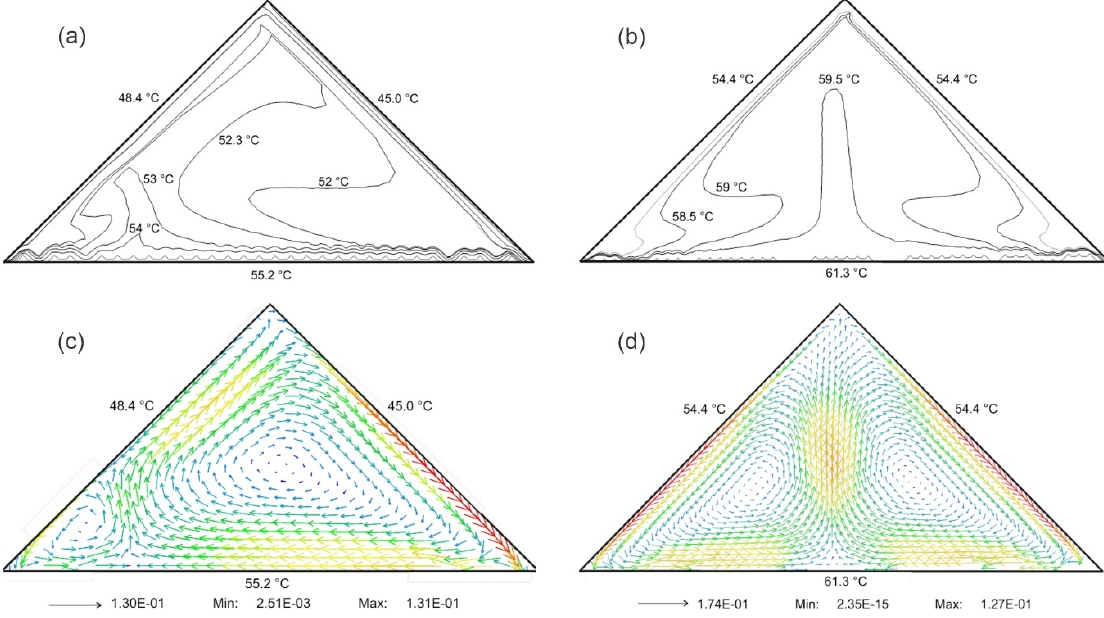
Figure 8. Isotherms ( a ) and fluid flow ( c ) in a cavity of triangular cross section heated from below with side walls at di ff erent temperatures, and isotherms ( b ) and fluid flow ( d ) for side walls at the same